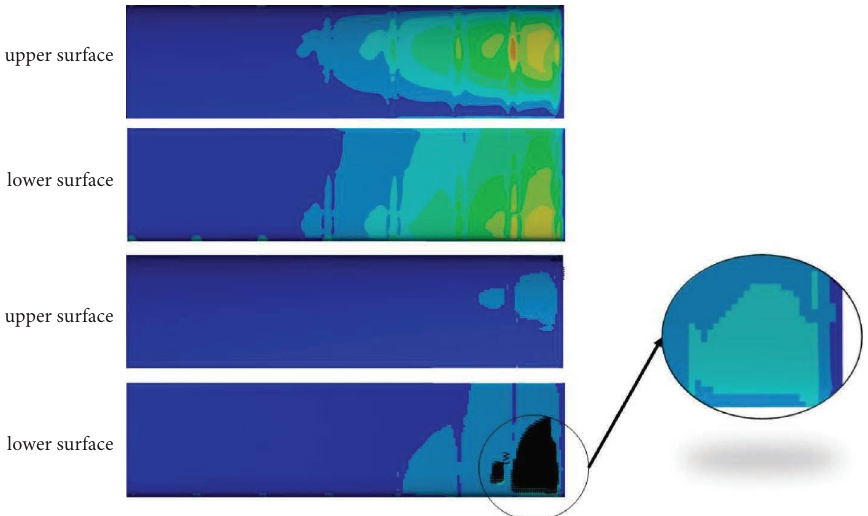
Figure 8: Strain-failure